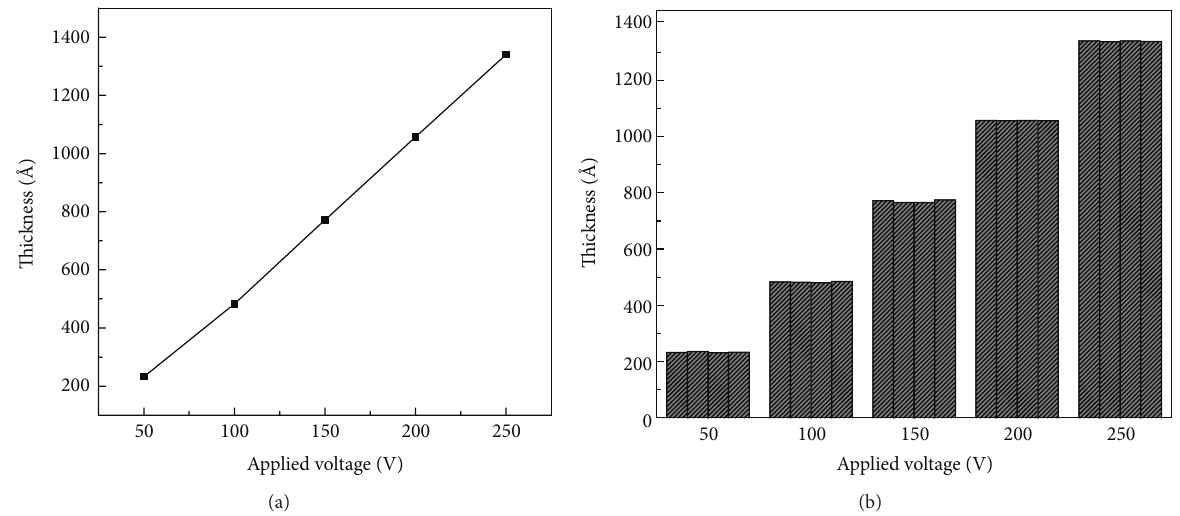
Figure 2: (a) Oxide thickness as a function of voltage in potentiostatic mode. (b) Oxide thickness measured at four different spots to observe thickness uniformity.